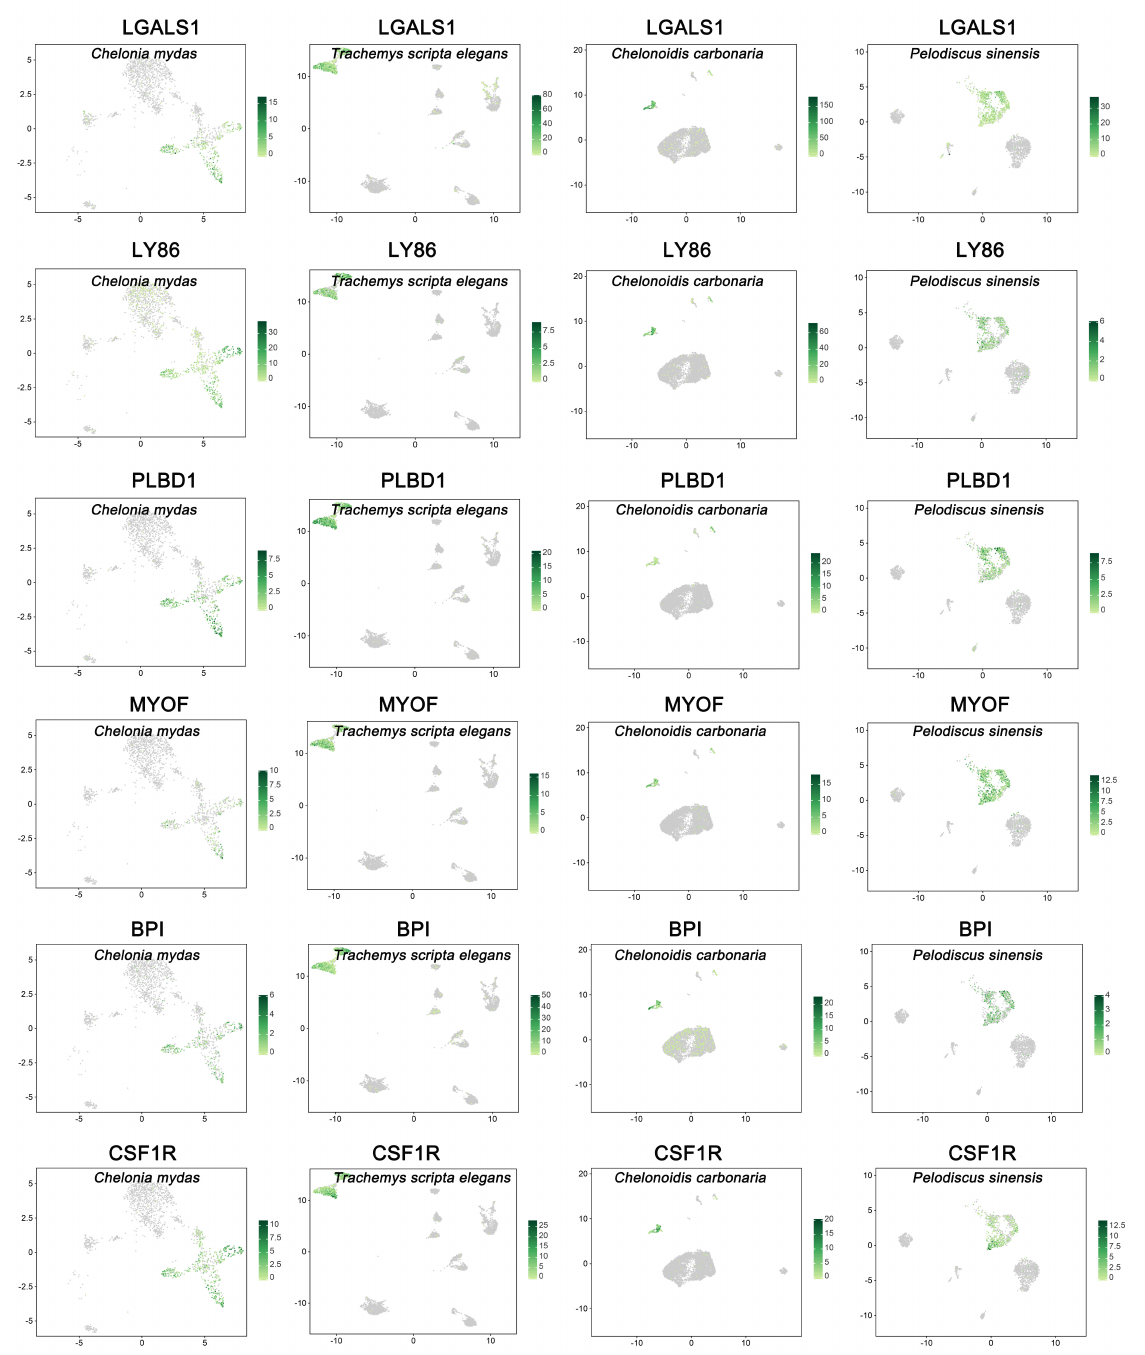
Figure 1. Canonical cell markers of monocytes were used to label clusters by cell identity as repre- sented in the UMAP